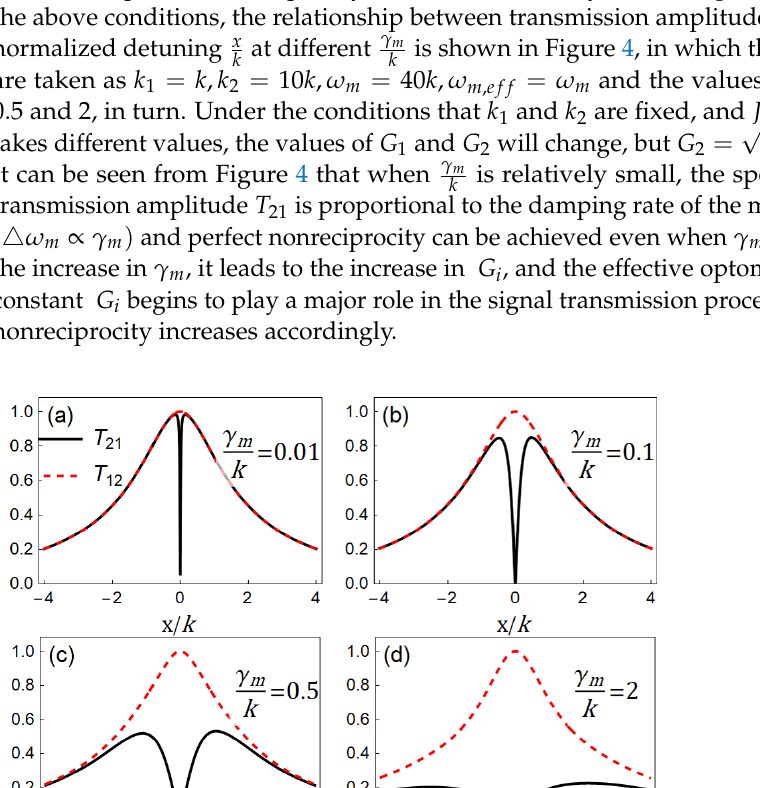
Figure 4. When (cid:2016) (cid:3404) (cid:3095) Figure 4. When θ = π (Black solid lines) and (cid:1846) (cid:2869)(cid:2870) (Red dashed lines) vary with the normalized detuning (cid:3051) (Black solid lines) and T 12 (Red dashed lines) vary with the normalized detuning x for different values of (cid:3082) (cid:3288) for different values of γ m parameters are as follows: J = 1